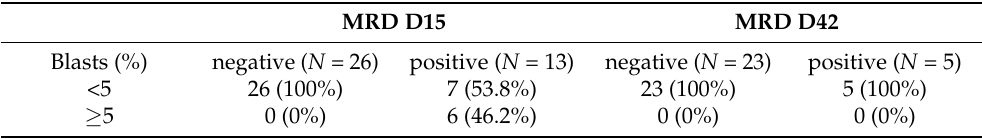
Table 4. Distribution of patients with morphological remission versus immunological remission on days 15 and